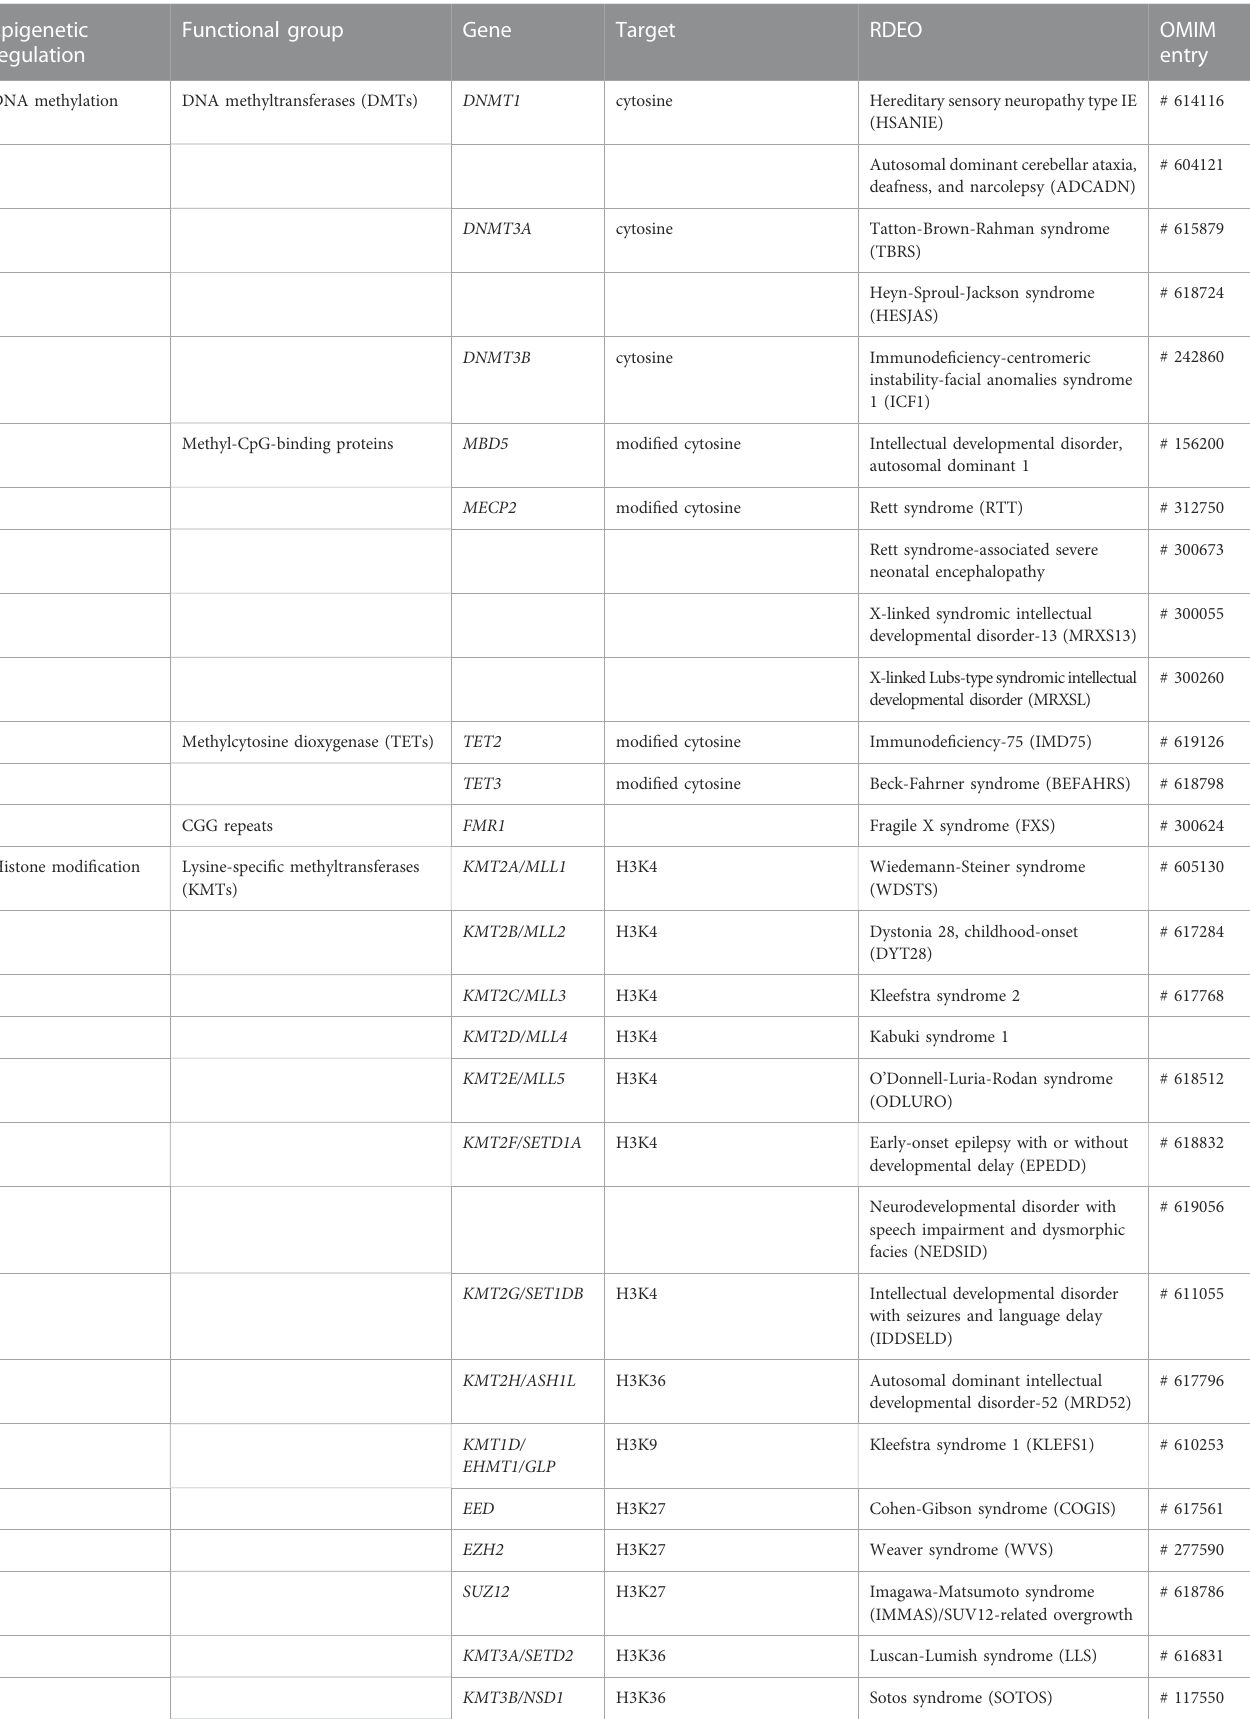
TABLE 1 Known RDEOs and corresponding genetic origins and functional targets (if available). Curated based on information available in the OMIM database (https://